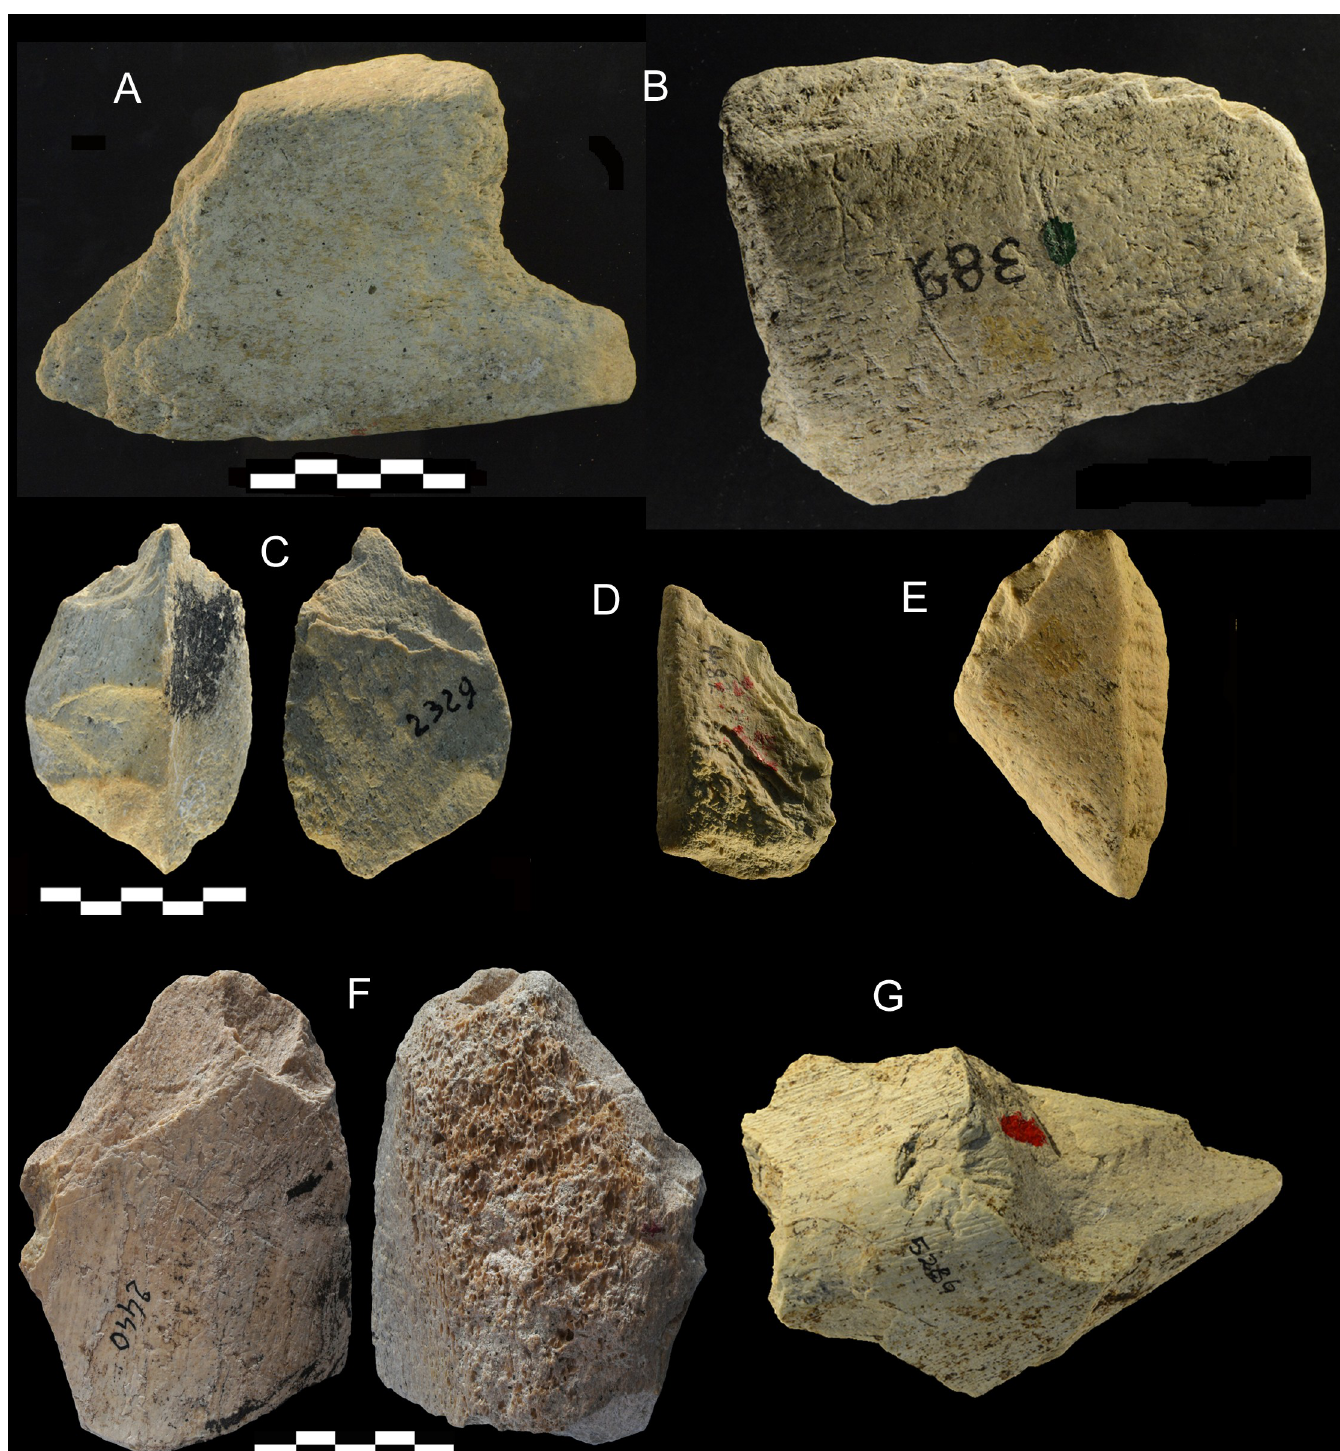
Fig 15. Castel di Guido. Retouched flakes (A, B, E), small tools on flakes (C, D) and broken tools (F, G). C is a bec on flake, D is a denticulate on flake. F has a stepped fracture at its base. The base of G is an irregular fracture and a percussion point in the center, probable cause of the break. This is most likely an intentional